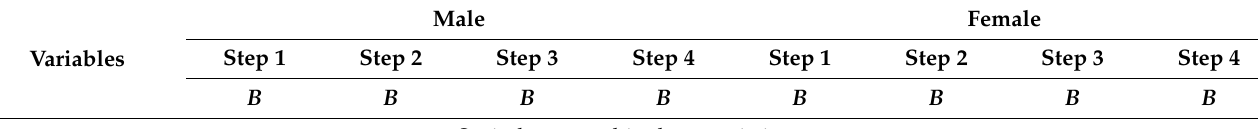
Table 3. Hierarchical multiple linear regression on positive affect by associated psychosocial and health related-factors in the 19–25 y age group based on